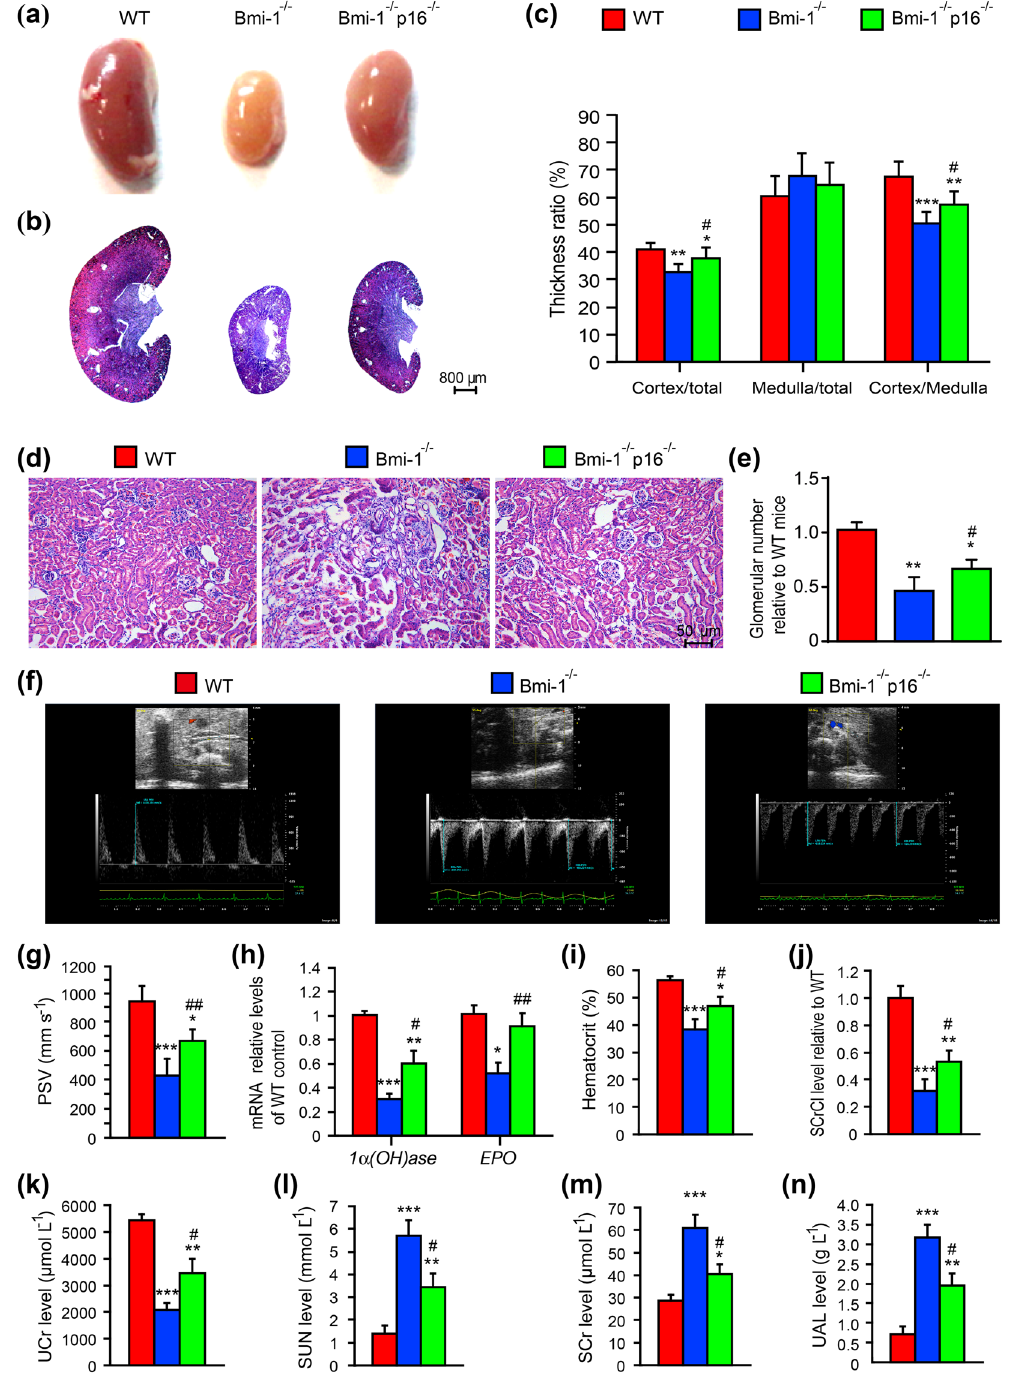
Figure 1. P16 deletion improved impaired renal structure and function in Bmi - 1 − / − mice. ( a ) Representative kidneys from 5-week-old Bmi - 1 − / − , Bmi - 1 − / − p16 − / − and WT mice. ( b ) Representative micrographs of kidney longitudinal sections stained with HE. ( c ) Thickness ratios for cortex/total, medulla/total and cortex/medulla. ( d ) Representative micrographs of renal cortex stained with HE. ( e ) Glomerular number relative to WT mice was determined in HE-stained sections. ( f ) Color Doppler flow imaging of peak systolic velocity (PSV) for kidneys from 5-week-old Bmi - 1 − / − , Bmi - 1 − / − p16 − / − and WT mice. ( g ) PSV measurements. ( h ) 1 α - hydroxylase ( 1 α ( OH ) ase ) and erythropoietin ( EPO ) mRNA in kidneys by real-time RT-PCR calculated as a ratio to GAPDH mRNA and expressed relative to WT. ( i ) Hematocrit percentages. ( j ) Serum creatinine clearance (SCrCl) levels relative to WT; ( k ) urine creatinine (UCr); ( l ) serum urea nitrogen (SUN) concentrations; ( m ) serum creatinine (SCr) levels; and ( n ) urinary albumin (UAL) levels determined by spectrophotometry. Six mice per group were used for these experiments. Values are means ± SEM of six determinations per group. * P < 0.05, ** P < 0.05, *** P < 0.001 compared with group; # P < 0.05, ## P < 0.01 compared with Bmi - 1 − / −